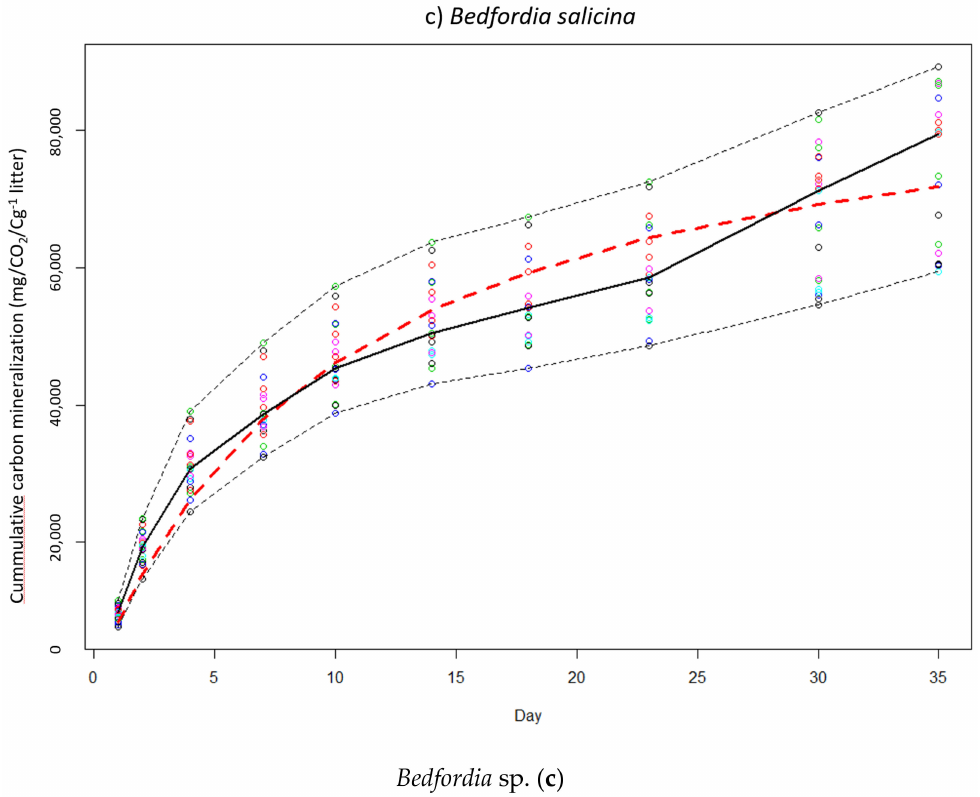
Figure 5. Cumulative carbon mineralisation rate over time (40 days) against all data points for each species. The red dotted line represents the Michaelis–Menten equation (MM) fit to the median data points. The black line is the median of the resampled data fits using the MM equation, with corresponding black dotted 95% confidence bounds: ( a ) E. obliqua initial MM fit ( R 2 : 93.3) and resampled median ( R 2 : 93.7%); ( b ) A. dealbata initial MM fit ( R 2 : 90.9%) and resampled median ( R 2 : 92.8%); ( c ) Bedfordia sp. initial MM fit ( R 2 : 89.1%) and resampled median ( R 2 :